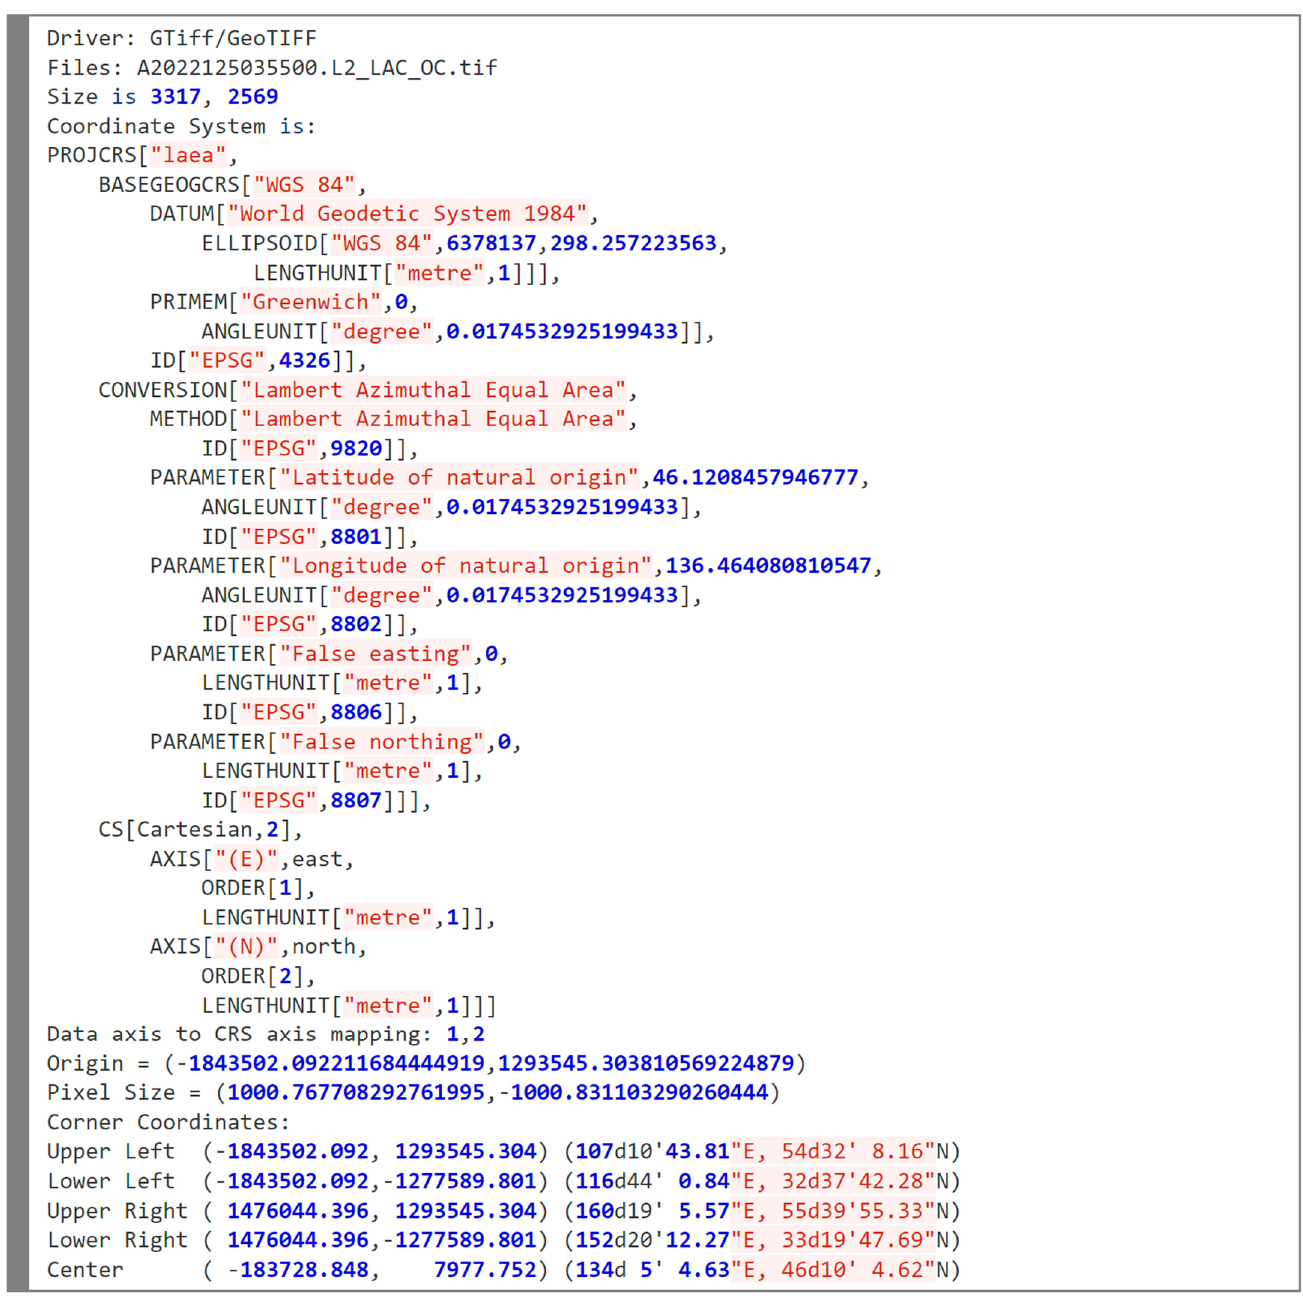
Figure A5. Example of coordinate system and image structure output by “ gdalinfo ” for the MODIS/Aqua target map projection. Note that the corner coordinates are reported in metric distances along with corresponding latitude and longitude values.